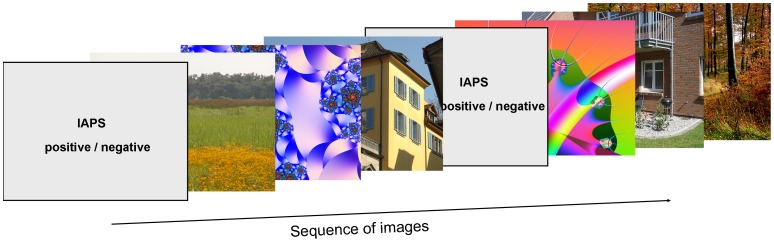
Sequence of images (example).One positive or negative IAPS image serving as prime was followed by three neutral target images belonging to the three different image categories (nature, urban, fractal), respectively. The emotional content of primes as well as the order of target images were randomized.